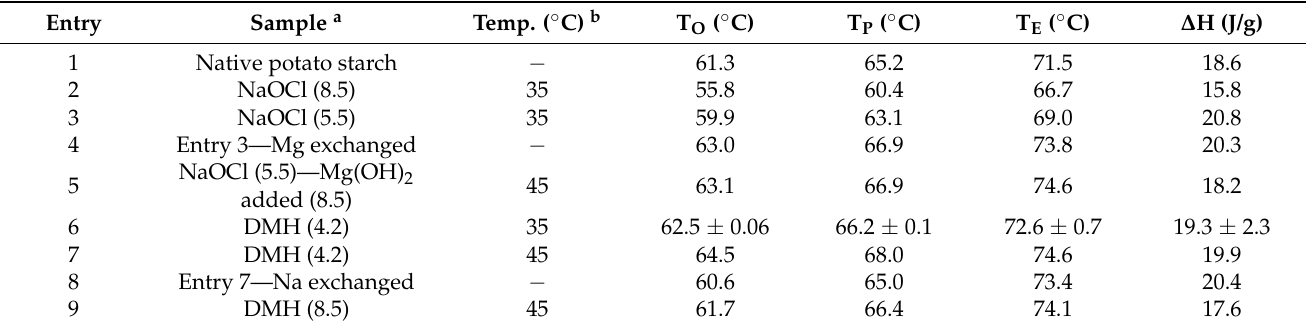
Table 2. Gelatinisation properties of NPS and starches oxidised with DMH and NaOCl as de- termined by DSC. T O = gelatinisation onset temperature; T p = gelatinisation peak